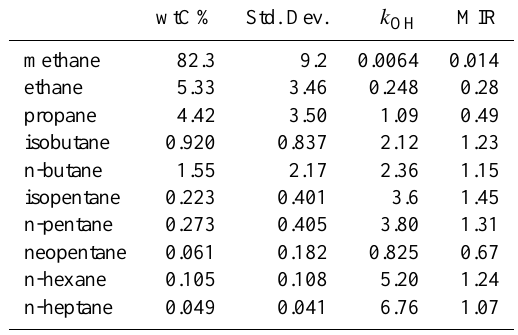
Table 1. Unrefined natural gas composition for thermogenic wet wells in the San Joaquin Valley from USGS samples ( N = 49 wells) (Lillis et al., 2007). wtC% Std. Dev. k OH MIR methane 82.3 9.2 0.0064 0.014 ethane 5.33 3.46 0.248 0.28 propane 4.42 3.50 1.09 0.49 isobutane 0.920 0.837 2.12 1.23 n-butane 1.55 isopentane 0.223 0.401 n-pentane 0.273 0.405 1.31 neopentane 0.061 0.182 0.825 0.67 n-hexane 0.105 0.108 n-heptane